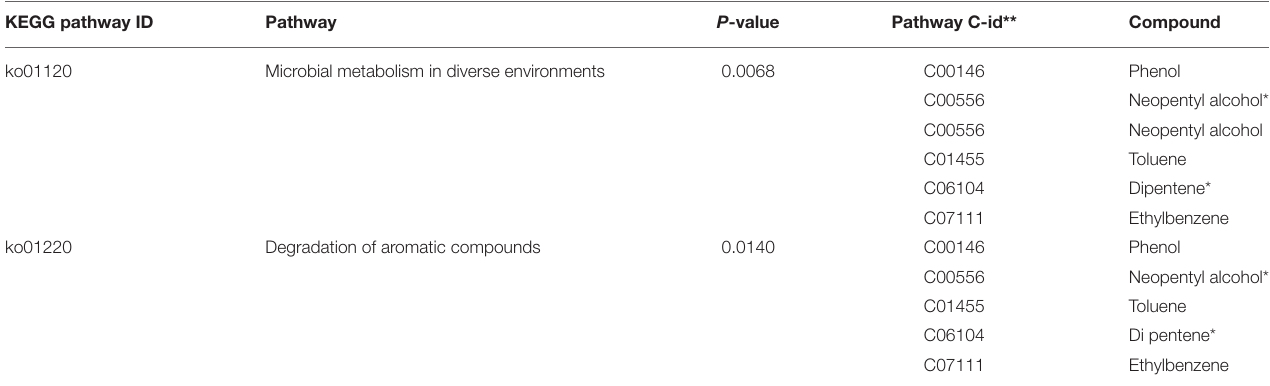
TABLE 3 | Common metabolic pathways of characteristic VOCs in exhaled breath and serum metabolites of patients in the CPA group. KEGG pathway ID